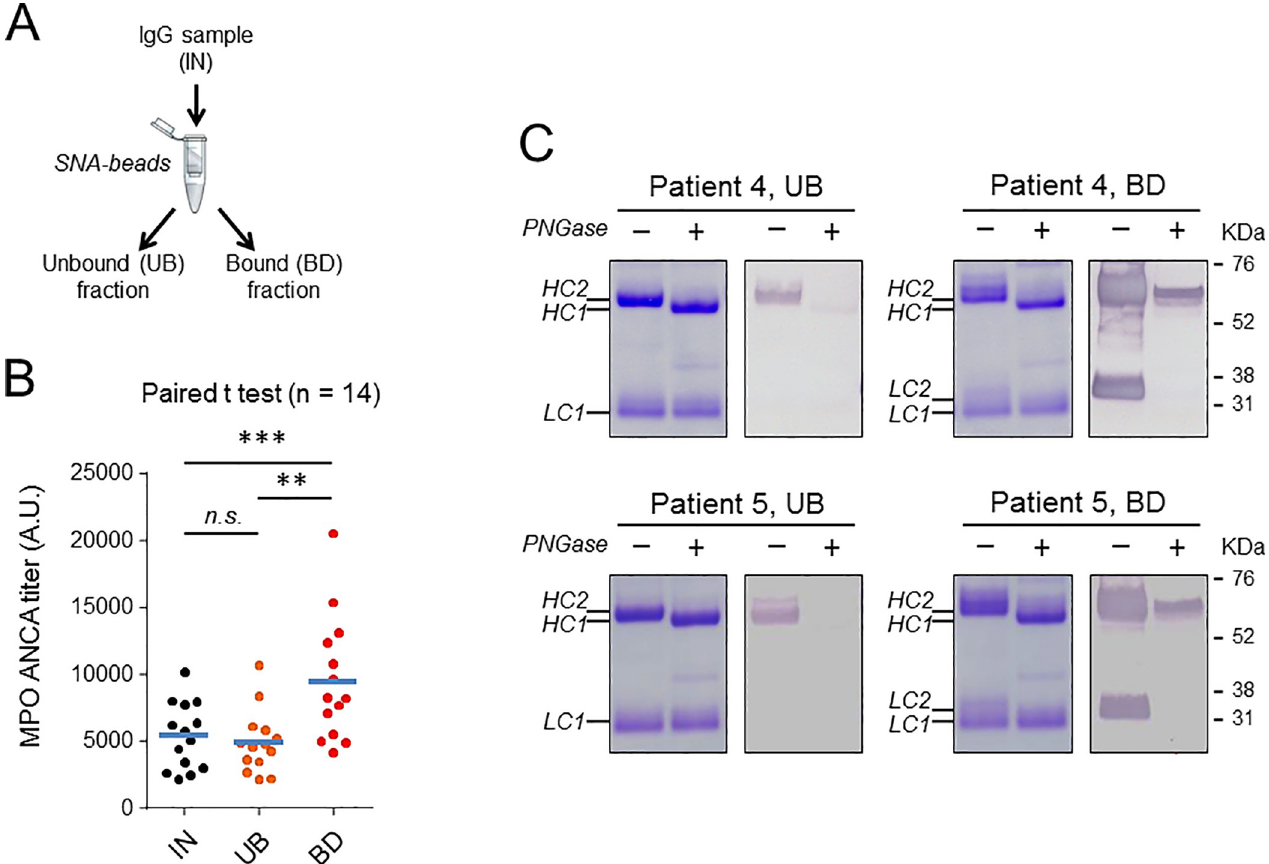
Fig 7. Anti-MPO titers and sialic acid content of SNA-enriched IgGs relative to unbound fraction. A: Scheme of the affinity pull-down assay. IN: sample before fractionation, UB: unbound fraction (Sialic-depleted IgG), BD: bound fraction (Sialic-enriched IgG). B: Determination of MPO-ANCA titers of IgG pull-down fractions by ELISA. Median values are indicated by blue horizontal bars. Statistical differences were analyzed using a paired Student’s t test. ��� : p < 0.001, �� : p < 0.01, n . s ., not significant. C: Separation of heavy and light chains of IgG pull-down fractions by SDS-PAGE under reducing condition. The protein bands were stained with Coomassie blue and their Sialic acid content was evaluated by lectin blot analyses. Samples in panel C were treated with (+) or without (-) PNGase-F prior to separation on SDS-PAGE. LC: light chain, HC: heavy chain, UB: unbound fraction (Sialic-depleted IgG), BD: bound fraction (Sialic-enriched